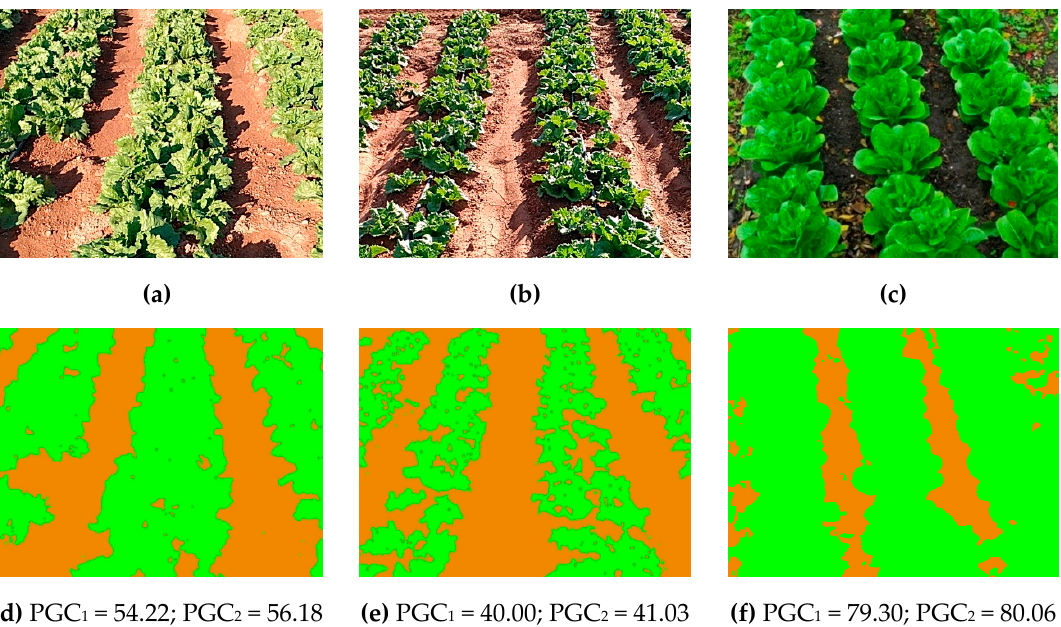
Figure 15. Generic color models for plants were applied in both cases.